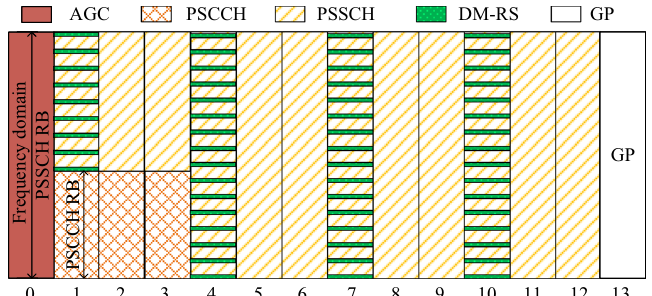
Fig. 2 Sketch map of the PSSCH time-frequancy structure